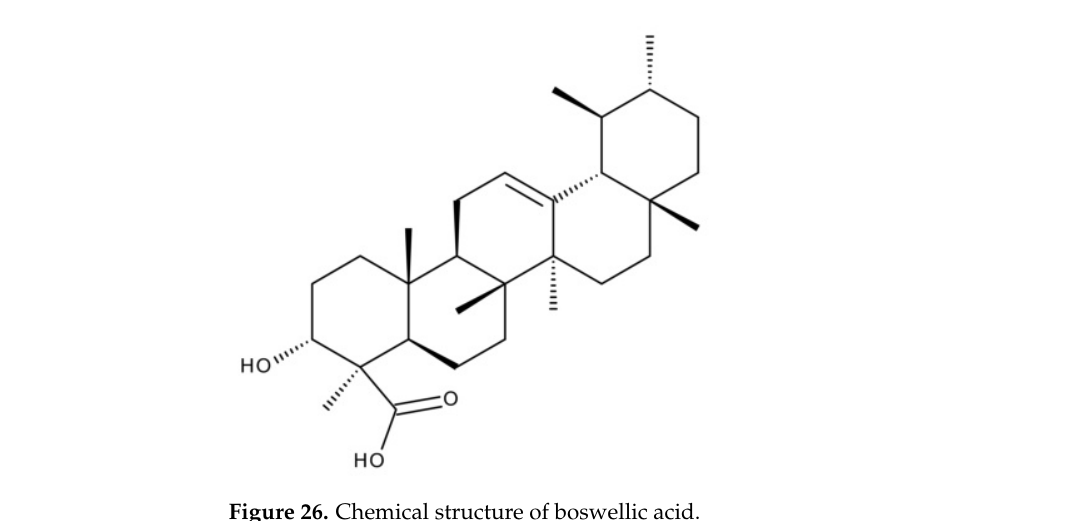
Figure 26. Chemical structure of boswellic